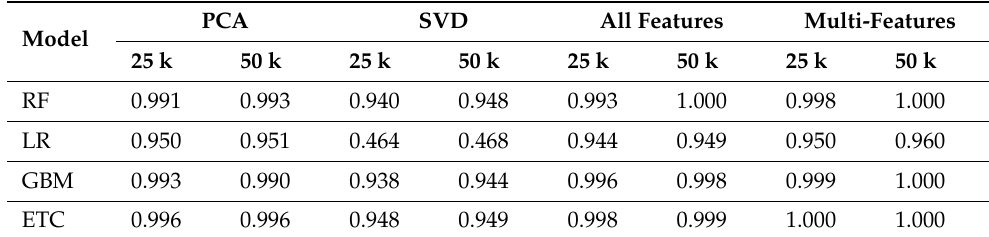
Table 10. Accuracy report of each learning model using different features.